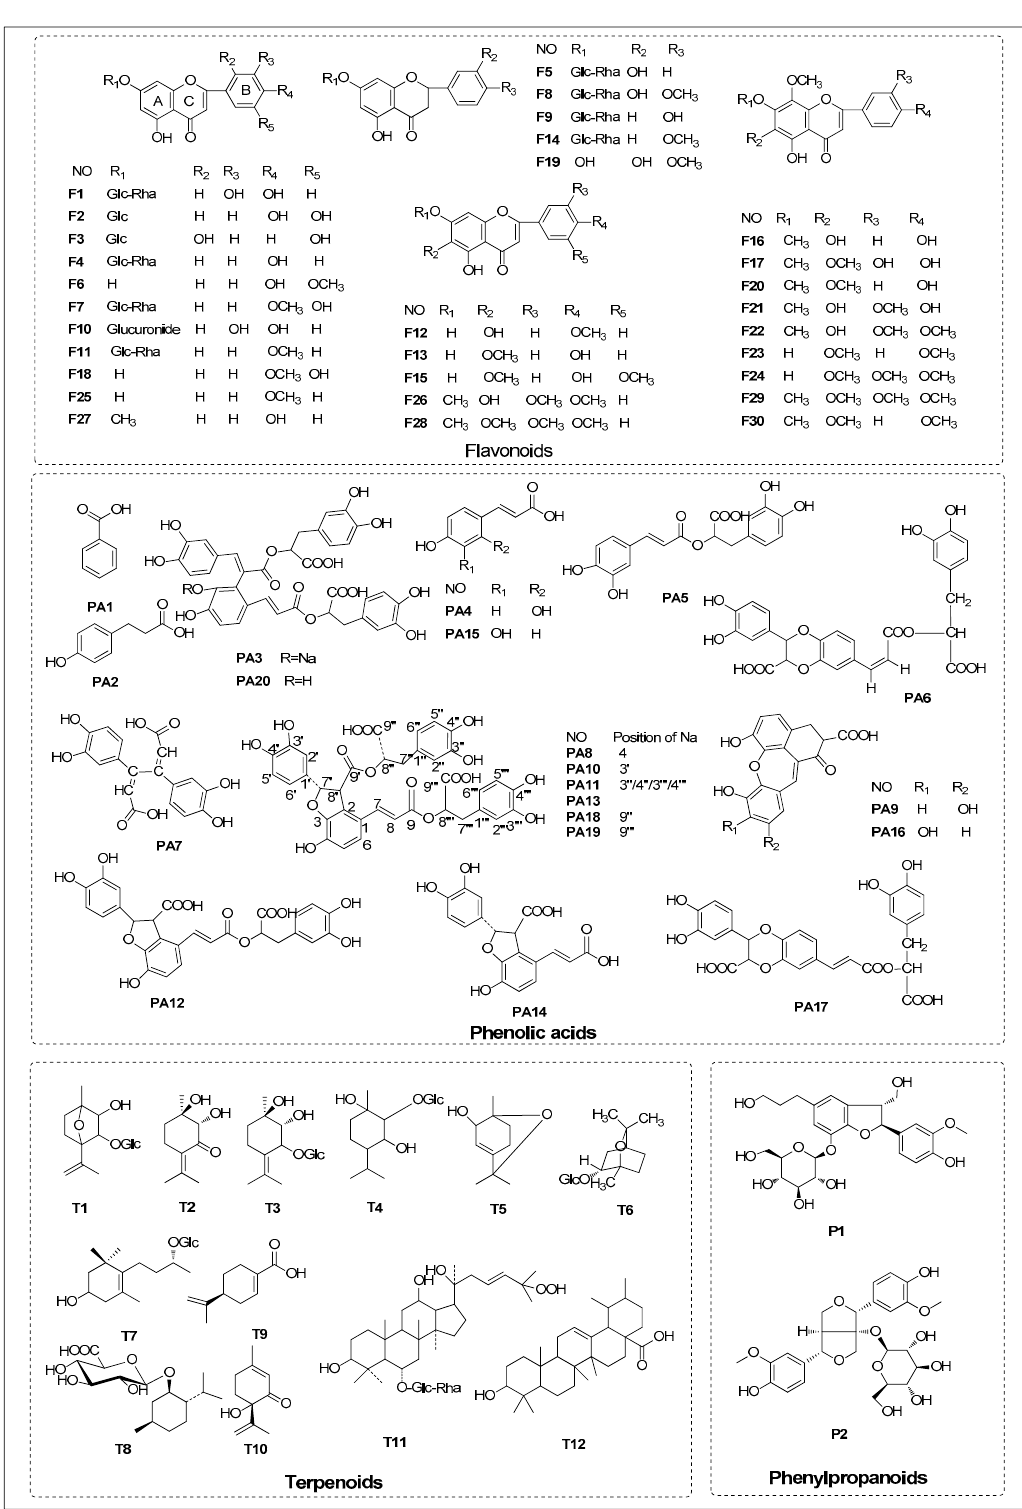
Figure 2. The structures of chemical constituents identified in Menthae Haplocalycis herba by UHPLC-ESI-MS/MS.